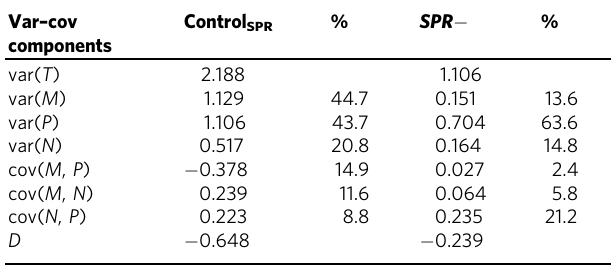
Table 2 Decomposition of the variance in male reproductive